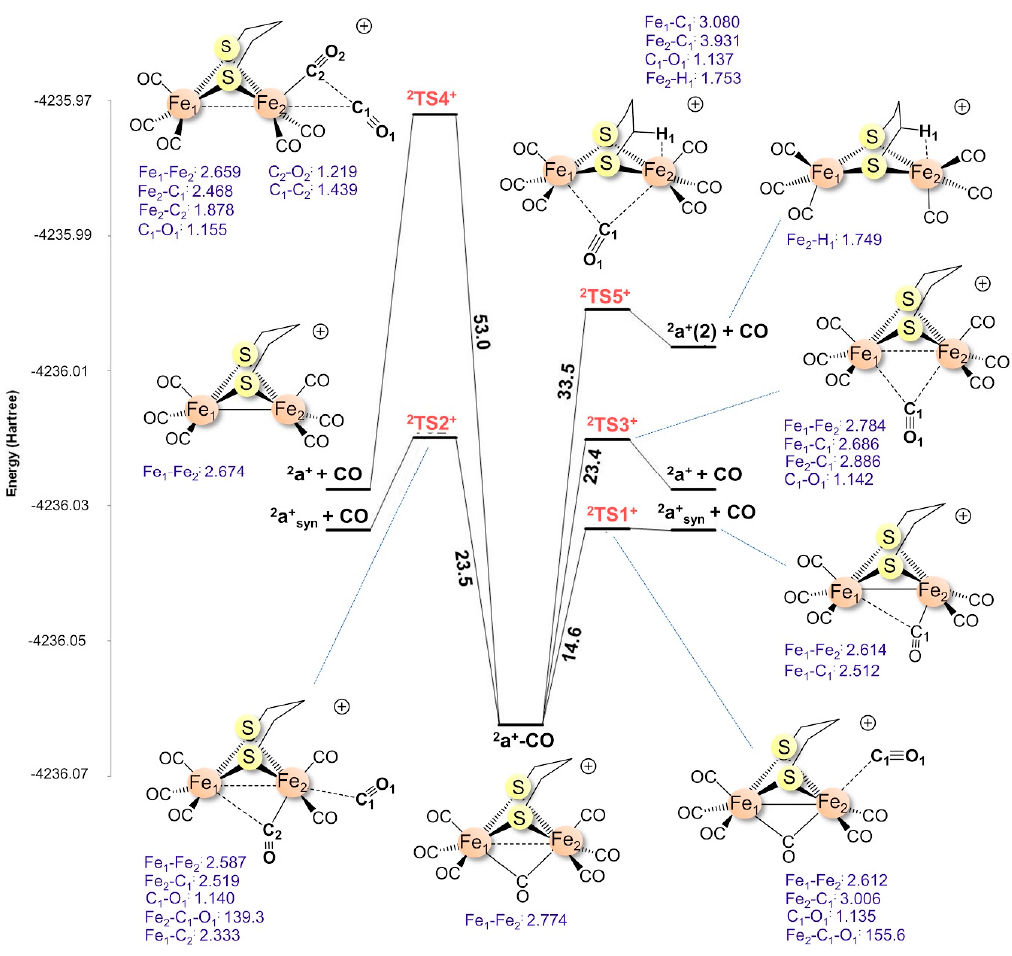
Figure 5. Total DFT energy diagram and optimized main geometry parameters of 2 a + –CO and cis syn , trans syn and µ -CO CO dissociation transition states and products. The energy in Hartree and free-energy barriers in kcal · mol − 1 . Distances are in Å and angles in degrees.